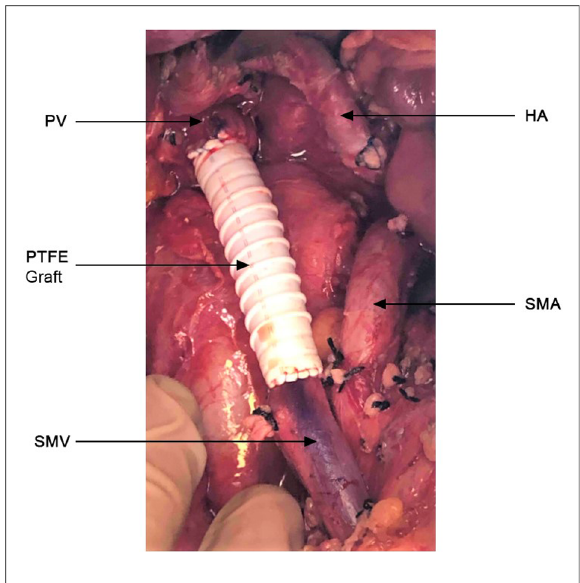
FIGURE 1 Complete skeletonization of the superior mesenteric vein (SMV) from its fi rst tributaries deep within the mesentery, portal vein (PV) up to the liver hilum, hepatic artery (HA) and superior mesenteric artery from their take off. PTFE graft (4.5 cm) placed at resected portion of the